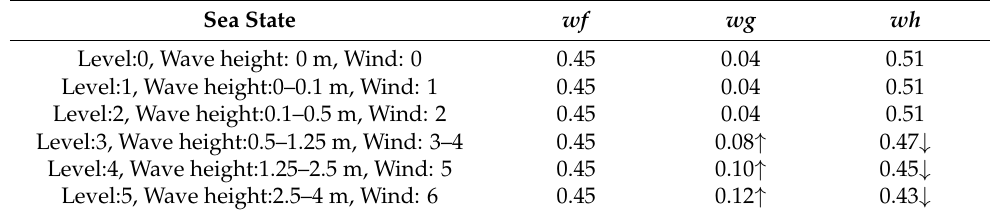
Table 1. Weight tuning under different sea states.